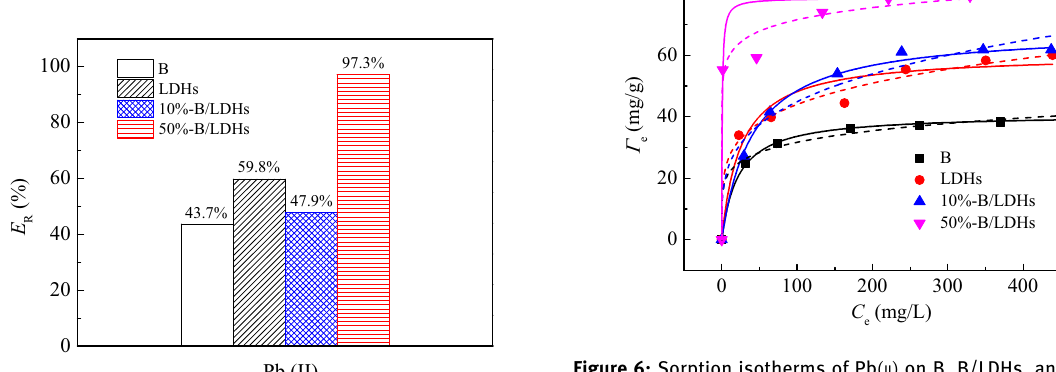
Figure 6: Sorption isotherms of Pb ( II ) on B, B/LDHs, and LDHs samples. C s = 1.0 g/L, C NaNO represent experimental data, the solid lines represent Langmuir Figure 5: Removal rates of Pb ( II ) on B, B/LDHs and LDHs samples. ( C = 50 mg/L, pH = 6.0 ) . C = 1.0 g/L, 25°C, and C = 0.010 M. model fi ts, and the dashed lines represent Freundlich model fi NaNO 3 0 s